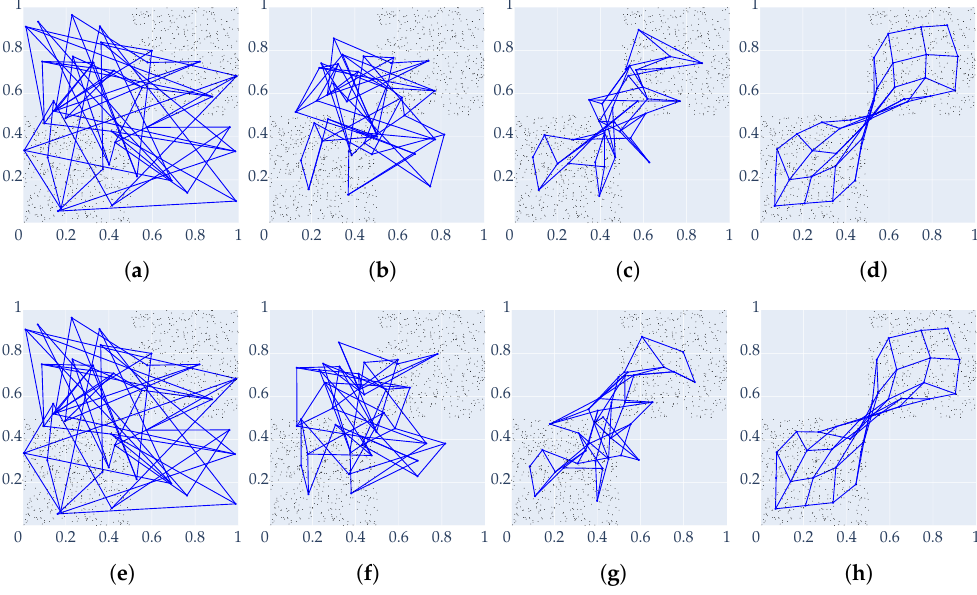
Figure 13. Comparative evolution of CSOM and ACSOM network during training over the same 1000 input vectors. ( a ) CSOM t = 0. ( b ) CSOM t = 10. ( c ) CSOM t = 100. ( d ) CSOM t = 1000. ( e ) ACSOM t = 0. ( f ) ACSOM t = 10. ( g ) ACSOM t = 100. ( h ) ACSOM t =